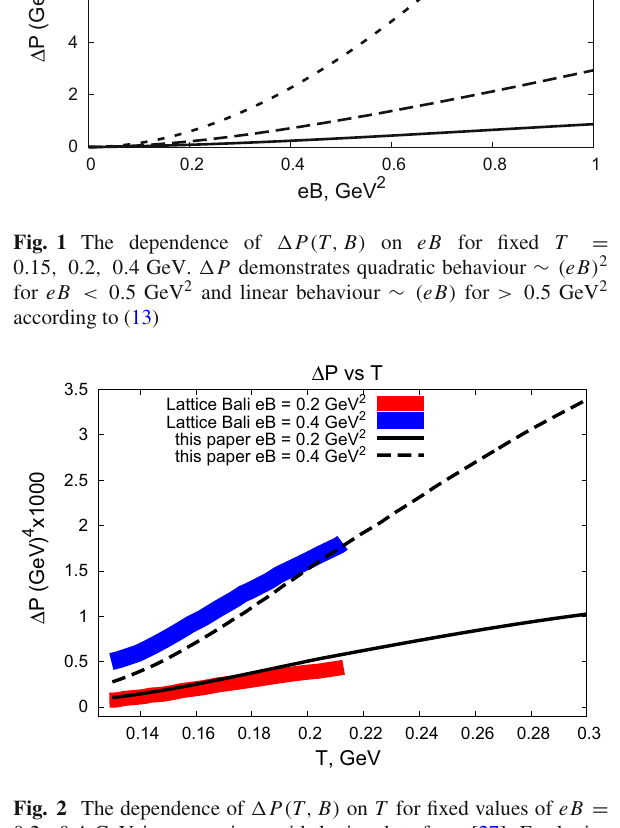
our results with the lattice scheme-independent longitudial pressure from [27]. In Fig. 2 are shown our calculations of (cid:12) P ( B , T ) for eB = 0 . 2 , 0 . 4 GeV 2 and m 2 (14) are compared with the lattice data from [27]. We have used in (14) the Polyakov line L ( T ) obtained in [28].